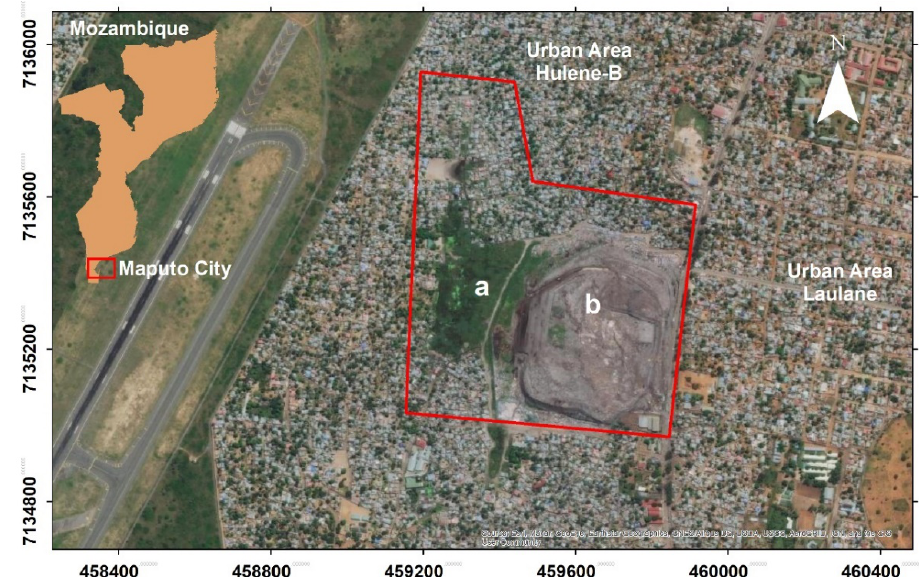
Figure 1. Study Area (a) intra dune depression; and (b) Hulene ‐ B waste dump. Geologically, the Hulene ‐ B waste dump is in the Mesocenozoic sedimentary basin, in southern Mozambique [36] in a contact zone of two lithologies (Ponta Vermelha TPv, and Malhazine QMa Formations) [27] (Figure 2). The Ponta Vermelha Formation dates from the upper Pliocene to the lower Pleistocene, being composed in the upper part of ferruginous sandstones and red silty sands, which gradually change to yellow and whitish sands [37]. On the surface this unit presents a red color, being poorly consoli ‐ dated, and loose sands may appear [26]. The Malhazine Formation, from the upper Pleistocene, consists of fine, poorly consolidated sands with whitish to reddish colors, fixed by vegetation on successive consolidation processes [26]. Waste deposition in the Hulene ‐ B dump is mostly located in QMa, spreading to the East (TPv). The eastern dump boundary corresponds to small slopes ranging from 52 to 54 m, while the western boundary presents smaller slopes, ranging 32 to 34 m (Figure 2b). Momade et al. [38] performed drillings L16 and L125 (Figure 2a) in two geological for ‐ mations around the dump, showing that TPv formation underlain QMa, and TSa (Mio ‐ cene ‐ Pliocene) is composed of clayey, calcareous sandstone with Ostrea cullata in its up ‐ per part.